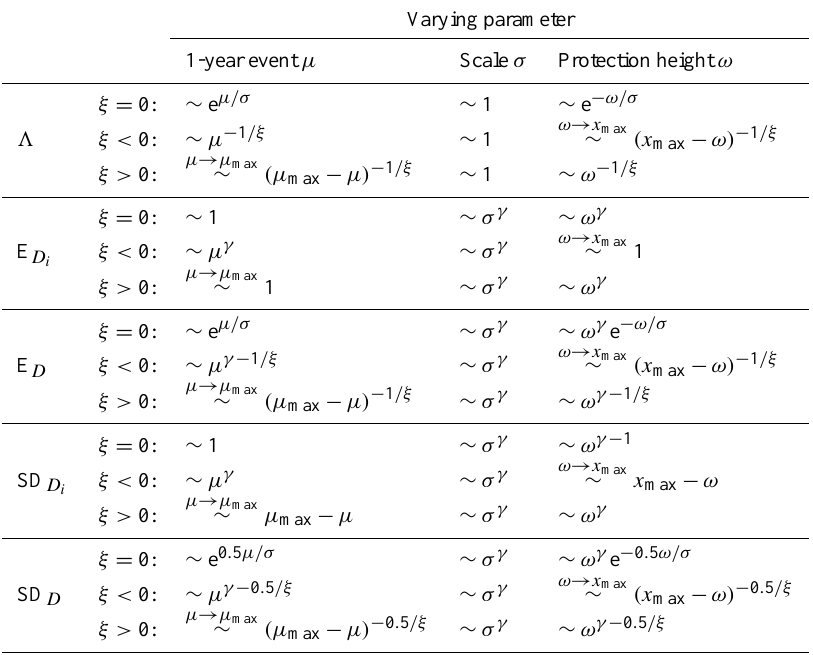
Table B1. The asymptotic behaviour of the number of annual flood events (cid:51) , the expected damage from a single event E D annual damage E D as well as the corresponding standard deviations SD D of all events), the scale parameter σ and the protection level ω . The values µ max = u + σ/ξ and x max = µ − σ/ξ represent upper limits for the parameters µ and ω in the case ξ > 0 and ξ < 0